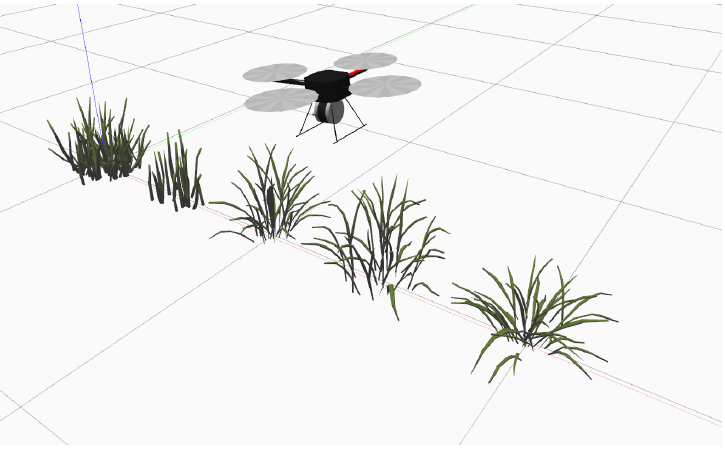
Figure 2. Grass models generated in Gazebo to populate the pasture terrain.